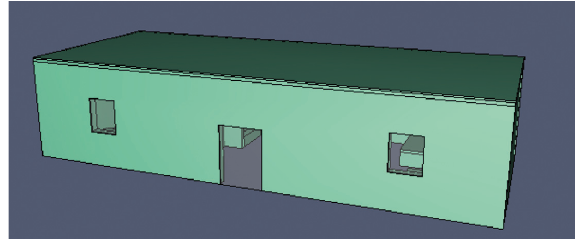
Figure 2: Flat roof building model.